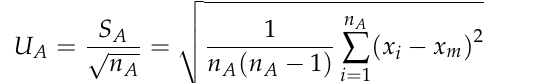
Figure 4. Measurement’s error and uncertainty.